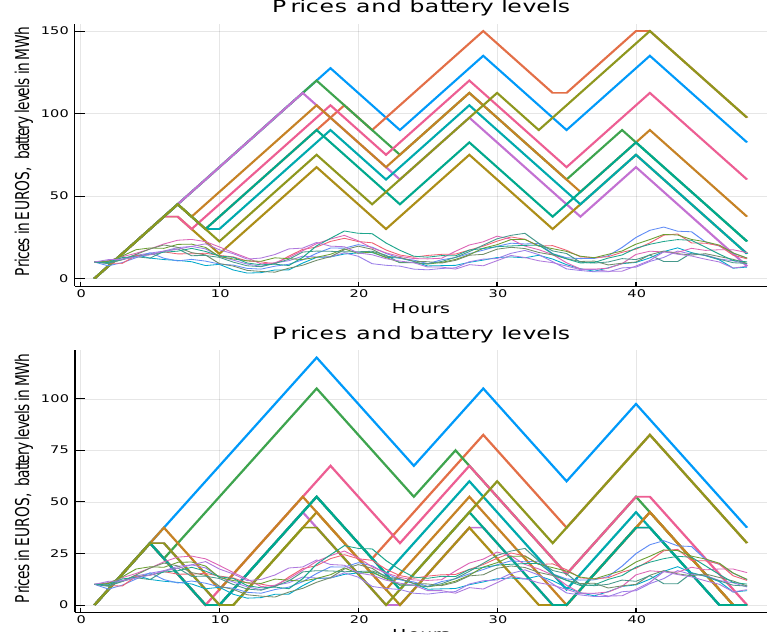
Figure 4. Forward electricity prices and battery levels based on the parameter values in Table 1, with η 1 = 100, η 2 = 15 ( upper plot ) and with η 1 = 0 ( lower plot ). The price trajectories, taken from the lower panel of Figure 3, are depicted in the lower part of each